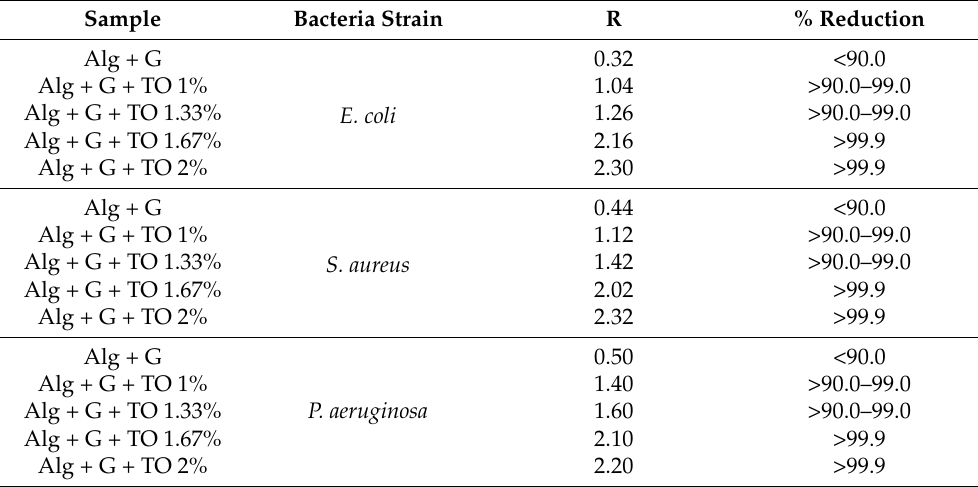
Table 6. Antibacterial activity of the studied samples against human